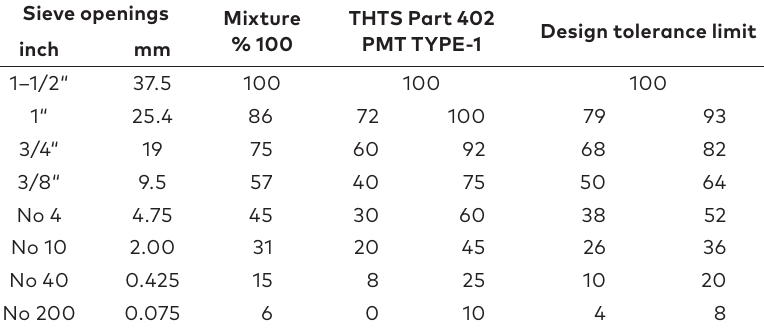
Table 2. TYPE-1 PM base layer mixture